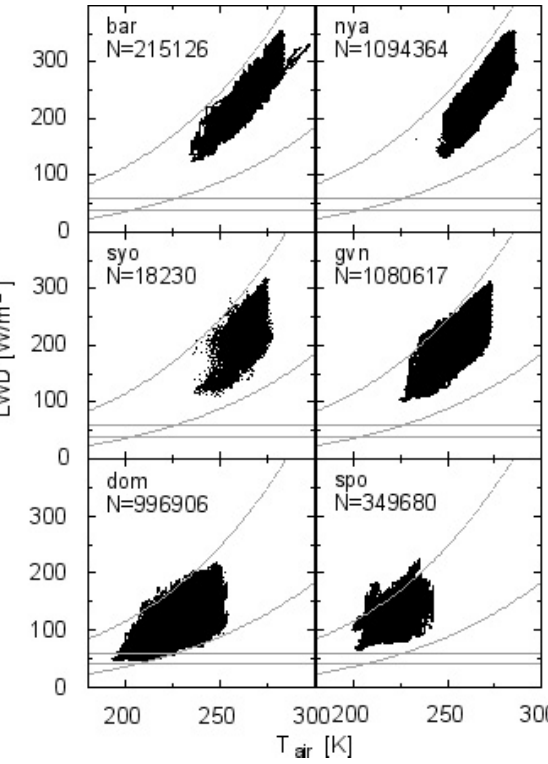
Figure 5. Downwelling Longwave to air temperature comparison. Horizontal lines represent the lower extremely rare limit erl l (upper one) and the lower physically possible limit ppl l . Curves represent the lower and the upper limits of downwelling longwave LWD to air temperature T a comparison (see Table